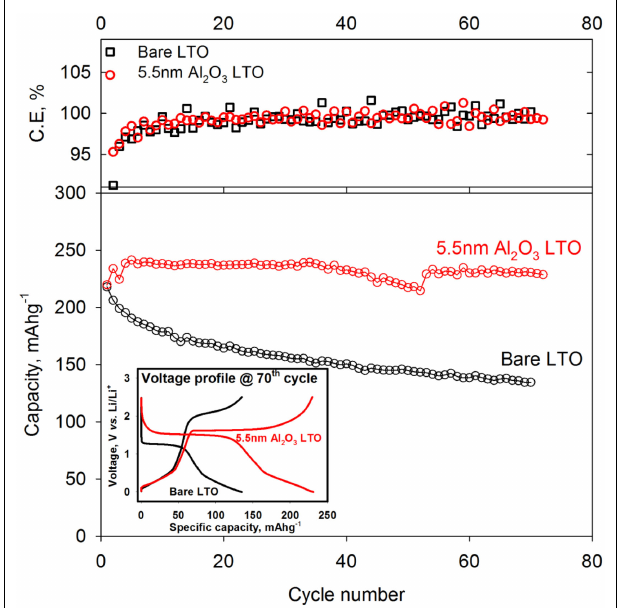
FIGURE 6 | C-rate capability of the pristine (gray), 2.2nm Al 2 O 3 -coated (red) and 5.5nm Al 2 O 3 -coated (blue) LTO electrode under the different working potential window; (A) 2.5V~1mV and (B) 2.5~1V . C-rate value was calculated by theoretical capacity and 1C rate in Figures 7A,B would be defined as 250 and 150mAg (cid:0) 1 ,